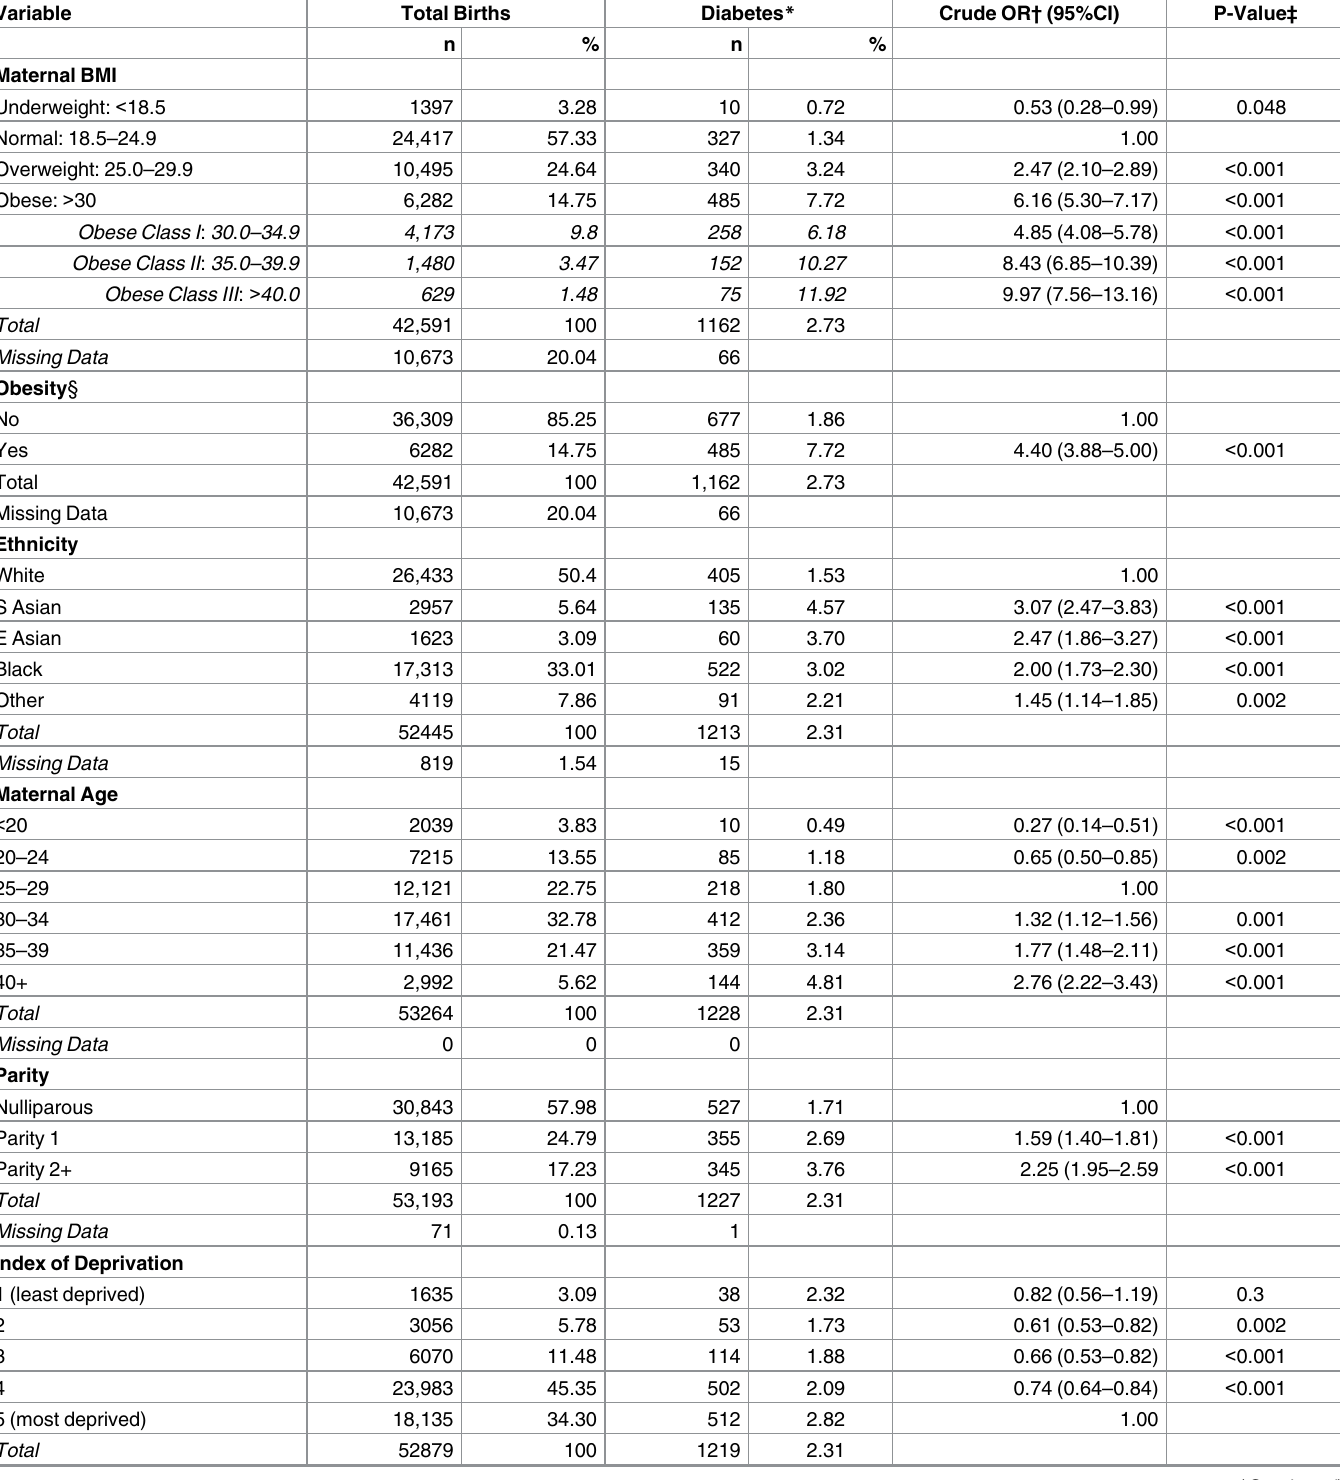
Table 1. Descriptivecharacteristics and univariate analysis of factors associatedwith diabetes in